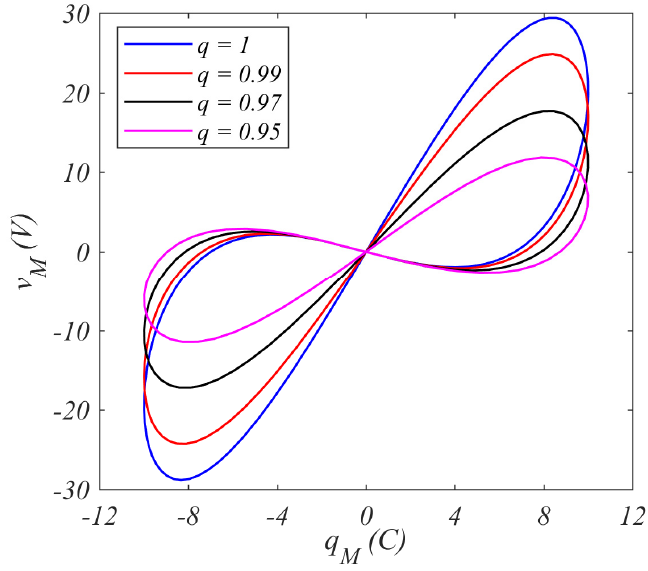
Figure 2. The q M − v M hysteresis loop characteristics of the fractional-order memcapacitor − 𝑣 Figure 2. The 𝑞 hysteresis loop characteristics of the fractional-order memcapacitor (11). (cid:3014) (cid:3014)